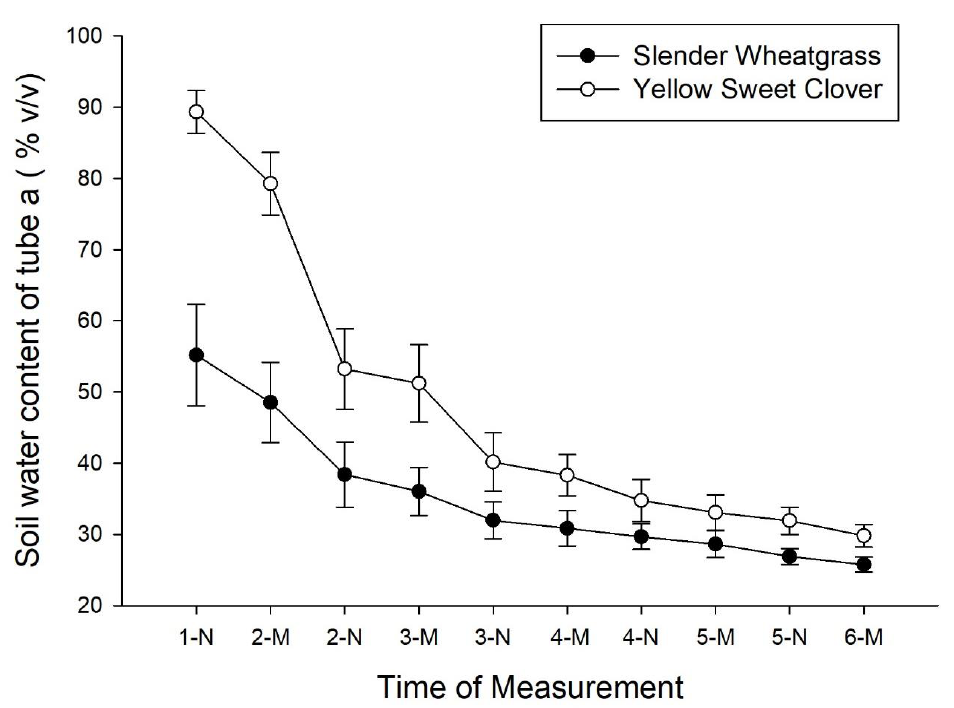
Figure 3. Diurnal patterns of soil volumetric water content in the upper PVC tube (part a) when the lower tube (part b) was placed in 2 L of the deuterium-enriched water in Study 2. Measurements were conducted at 6:30 in the morning (M) and at 21:30 at night (N). Means ± SE ( n = 5) are shown.